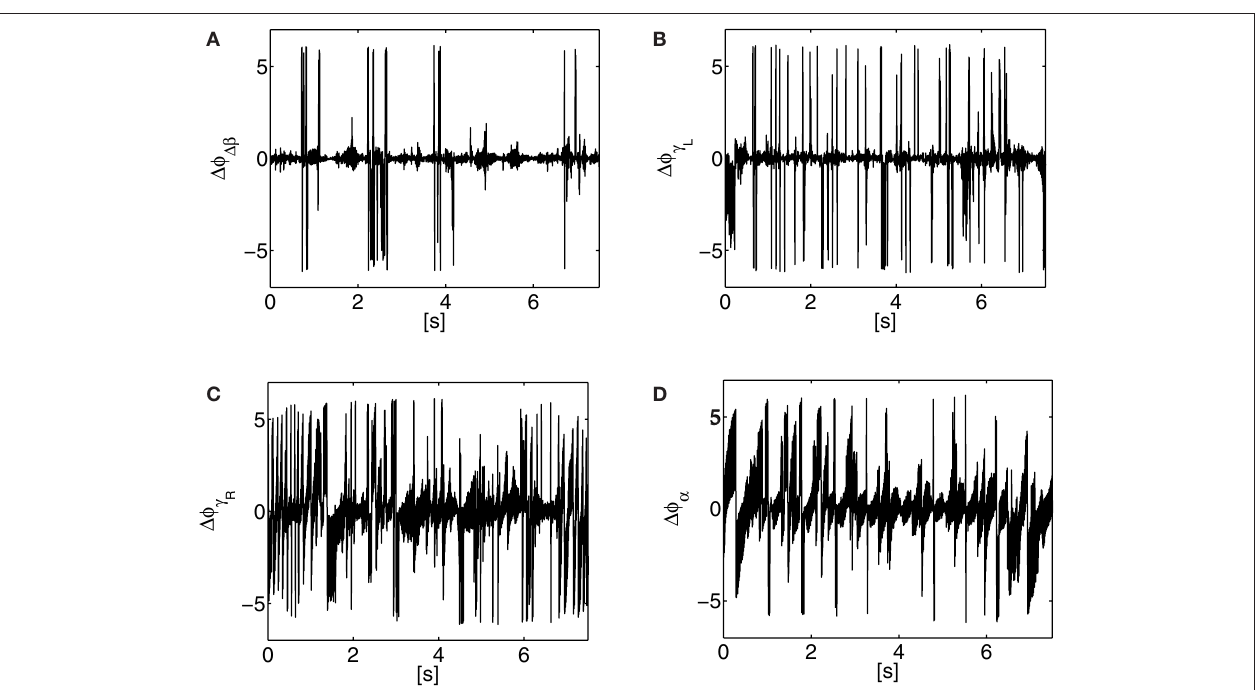
FIGURE 13 | Phase difference ΔφΔφ evolution between the biped sensors and motor dynamics during locomotion. The coordination in each joint is dynamic with lot of variance, however stable since centered in